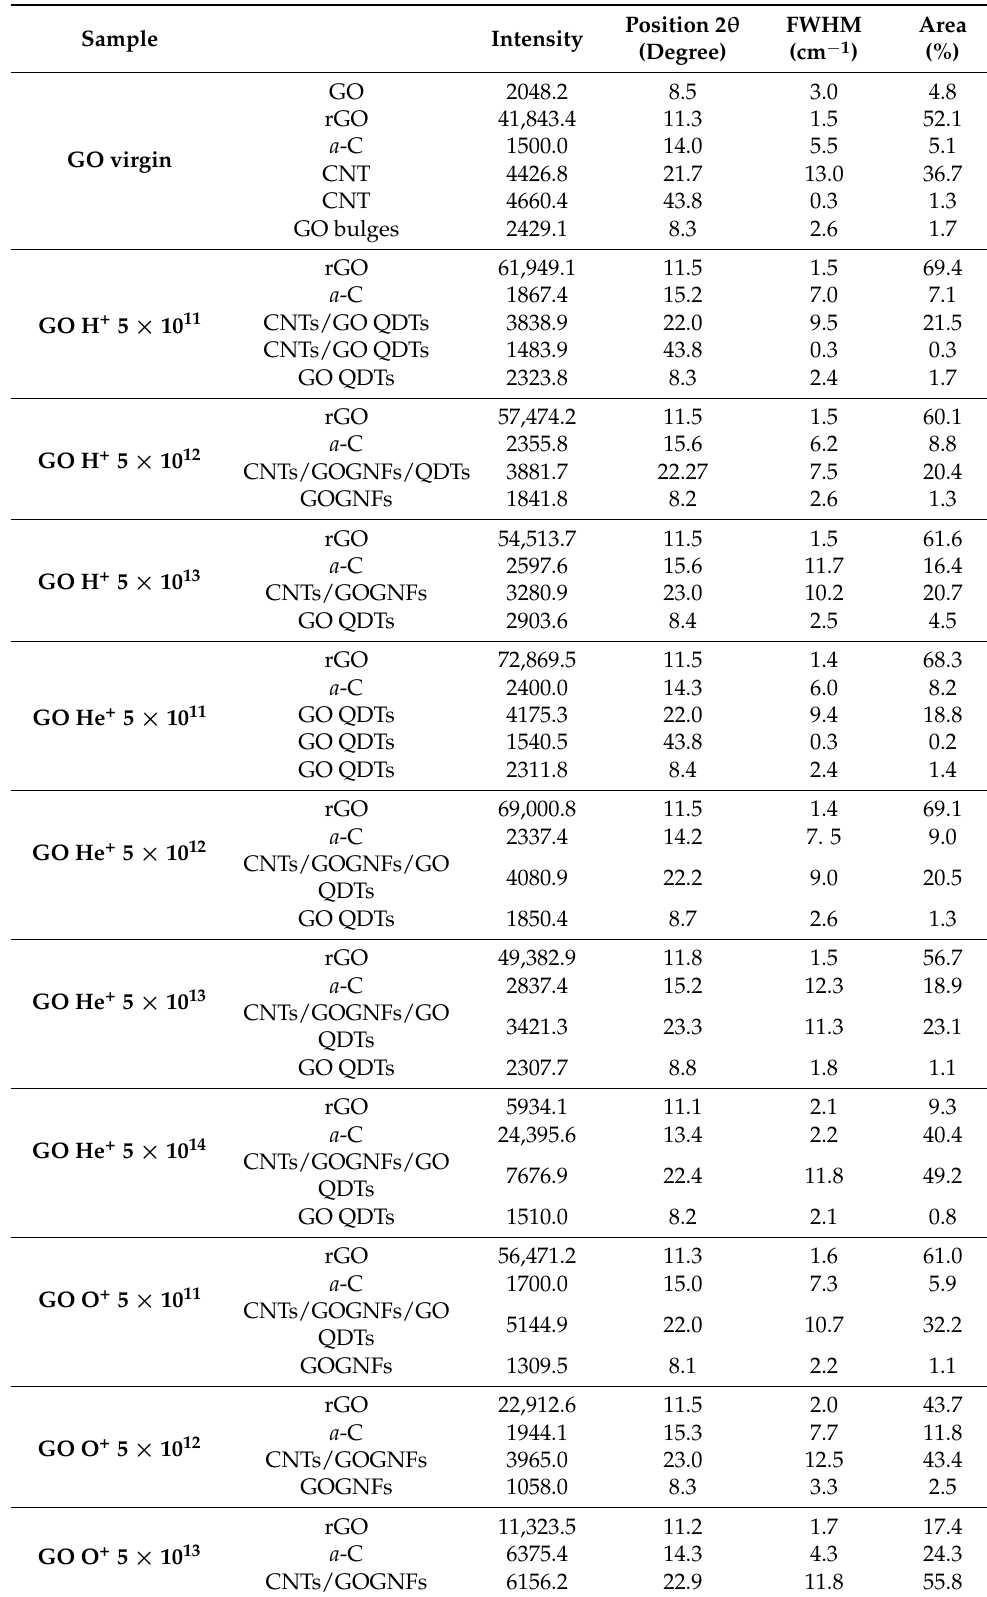
Table 3. List of the intensity, position, FWHM and area of the main features detected in the XRD curves deduced by the best fits for the unirradiated and irradiated GO sample areas [34].